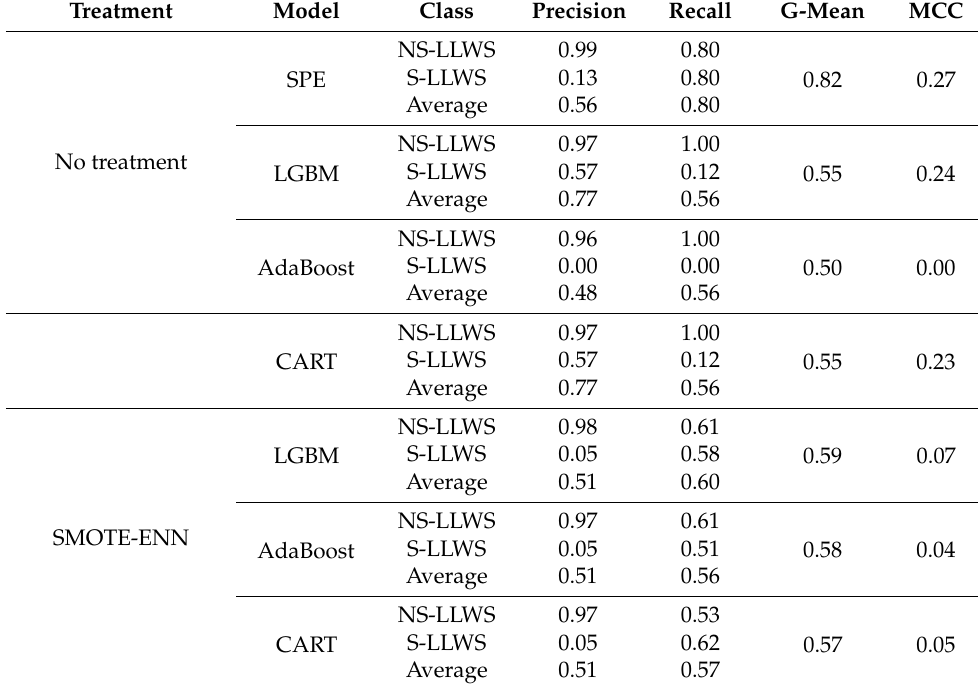
Table 3. Performance measure of machine learning models.